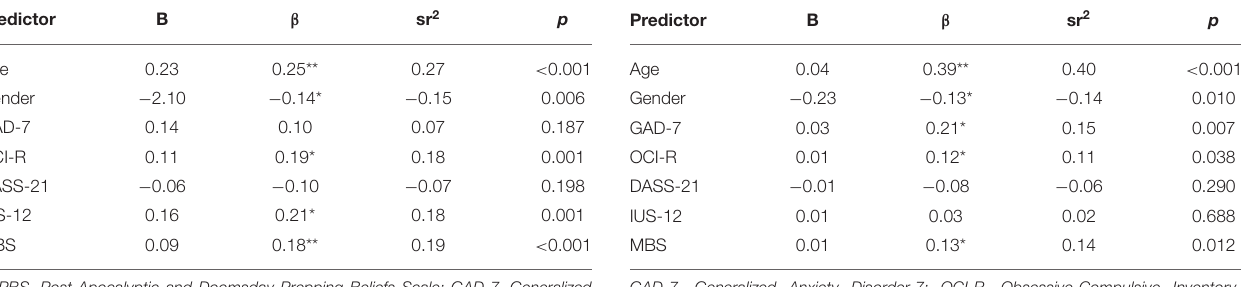
TABLE 8 | Linear Regression Predicting Stockpiling as measured be the Prepping and Coping during a Pandemic Scale (PCP-S) ( n = 373).